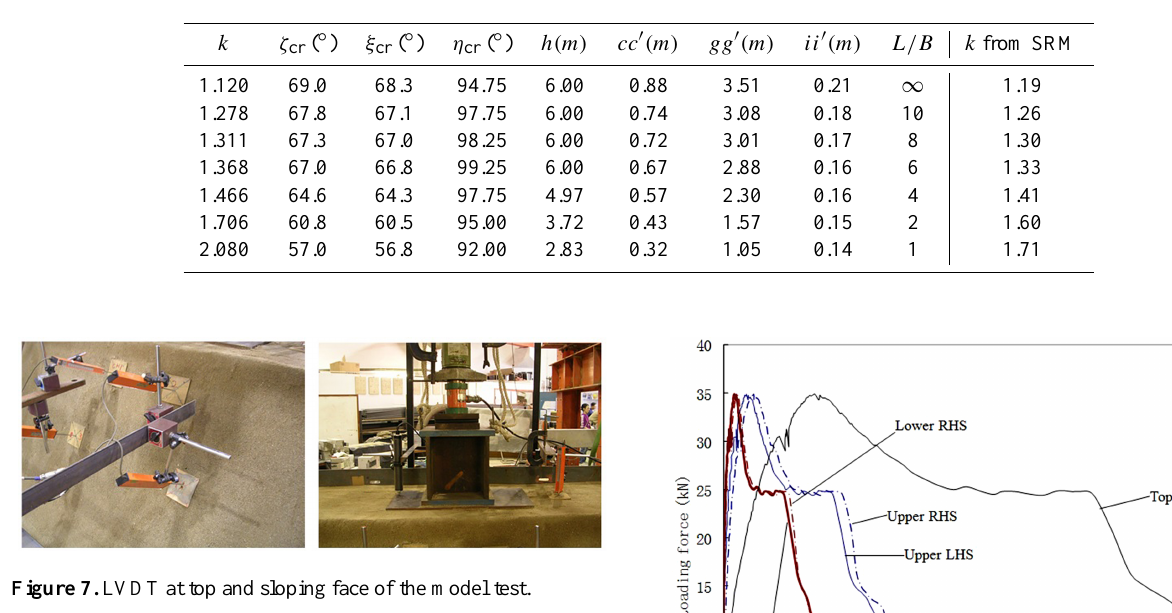
Table 1. Safety factors and geometric parameters (Example 1 and geometry of failure mass) for q = 100kPa.